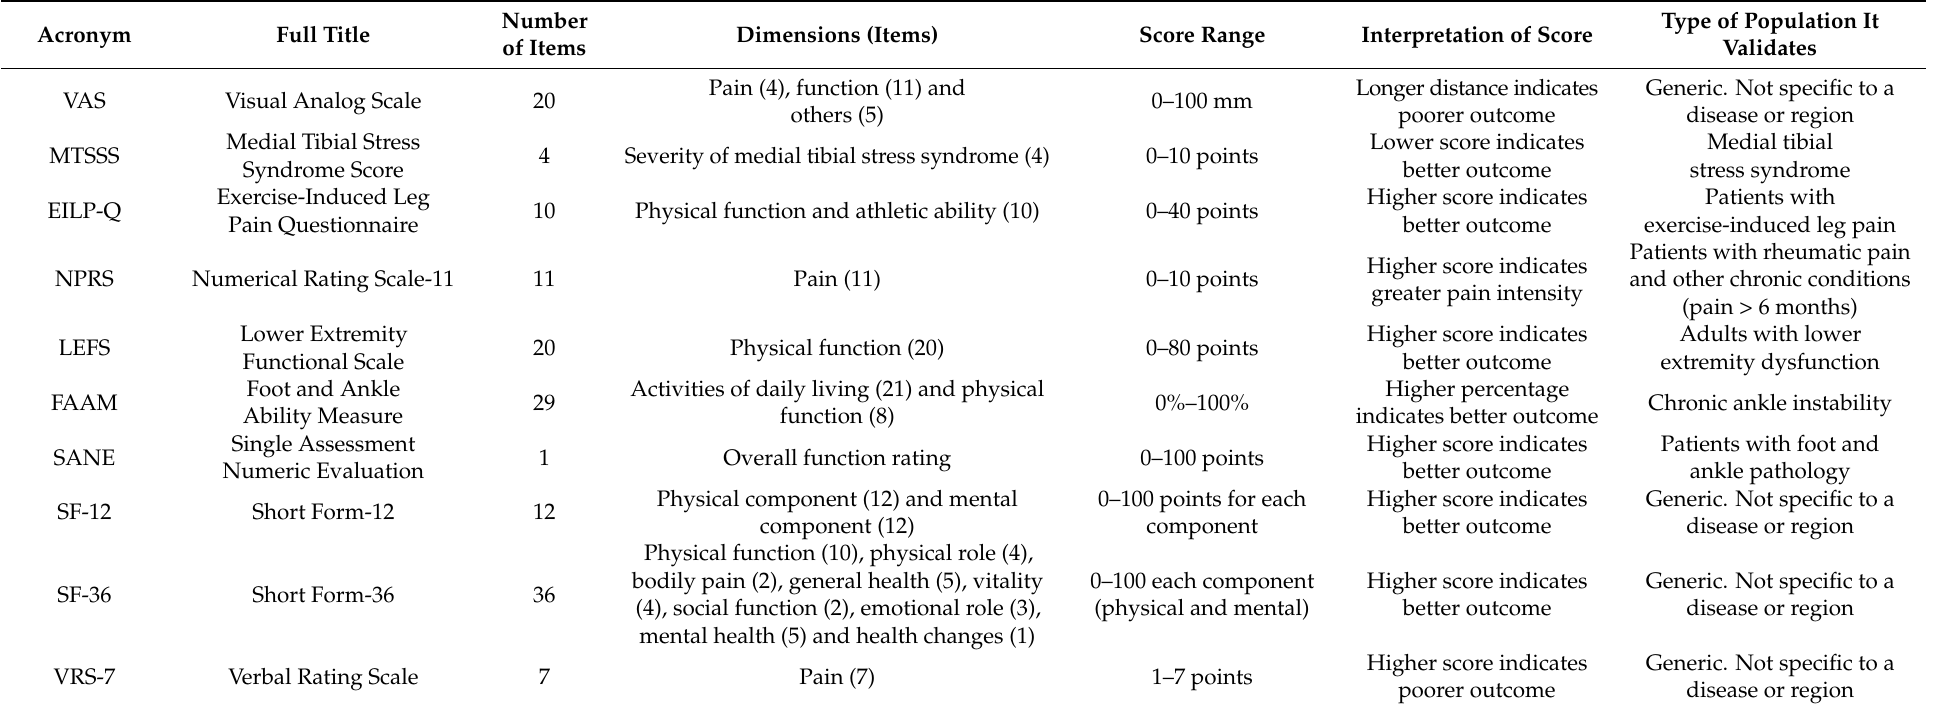
Table 1. Characteristics of the 10 most commonly used instruments in the assessment of patients with exercise-induced leg